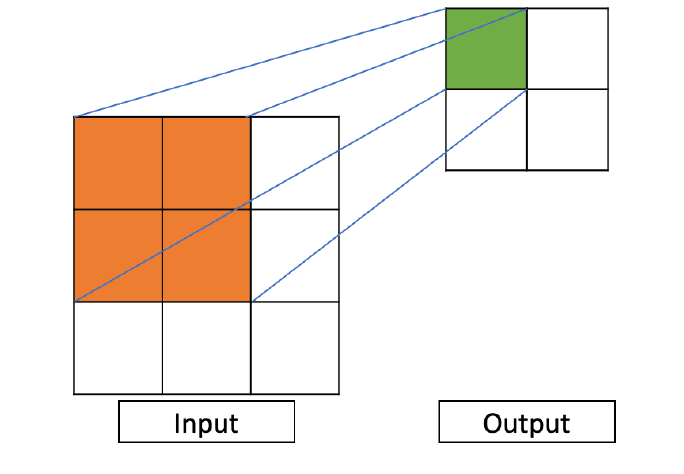
Figure 1. Example of how a convolutional filter operates in a fictitious 2D situation. In the input image, in orange, the filter is shown (in this case, a 2 × 2 filter); in the output image, in green, the resulting pixel obtained after applying the filter is shown. As shown, the data collected from a 2 × 2 pixels cell resulted in only one pixel in the output. This procedure was repeated through all the rows and columns by moving the filter, transforming a 3 × 3 image into a 2 ×